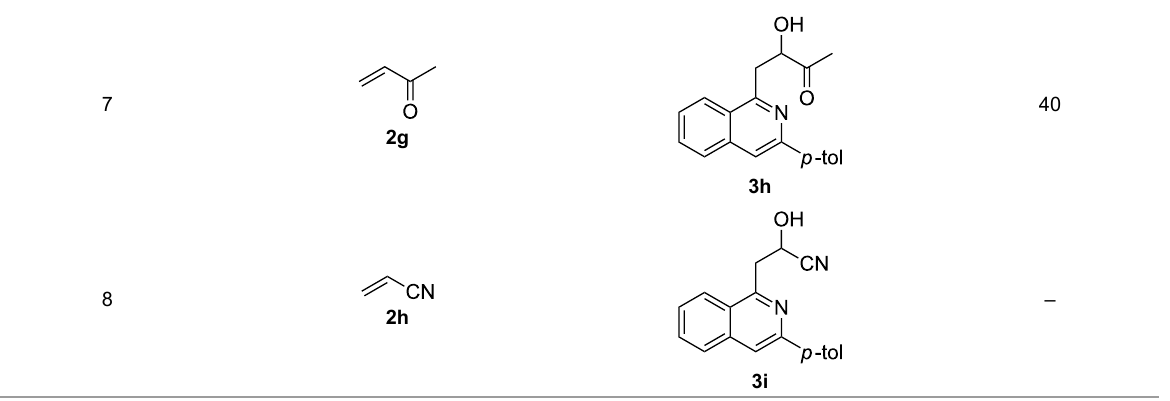
Table 1: AgOTf-catalyzed one-pot reactions of 2-( p -tolylethynyl)benzaldehyde oxime ( 1b ) with α , β -unsaturated carbonyl compounds 2 .